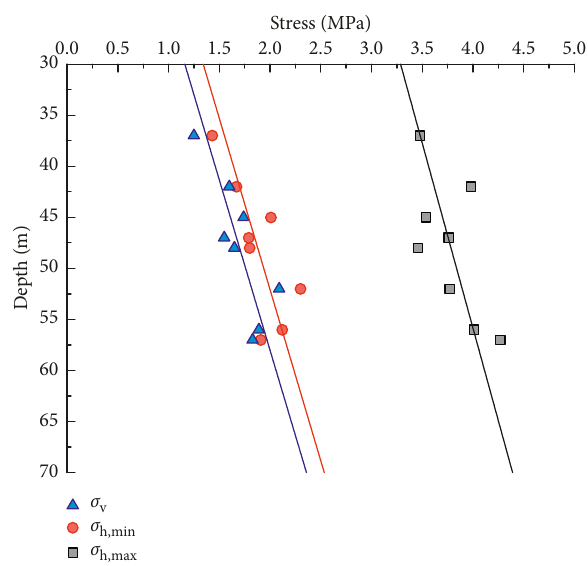
Figure 14: Trend of in situ stress along the